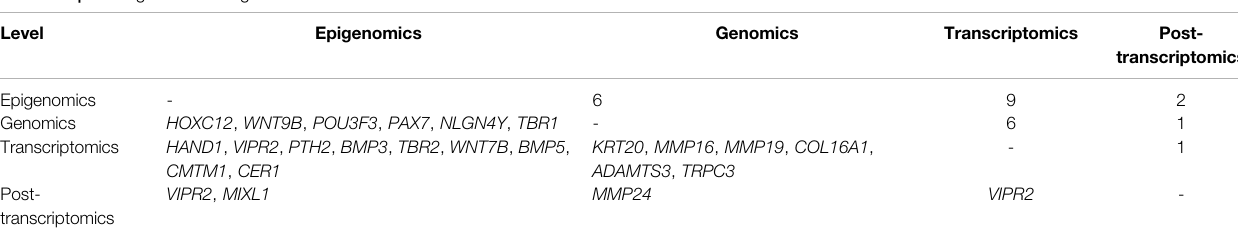
TABLE 2 | Driver genes involving two omics levels a